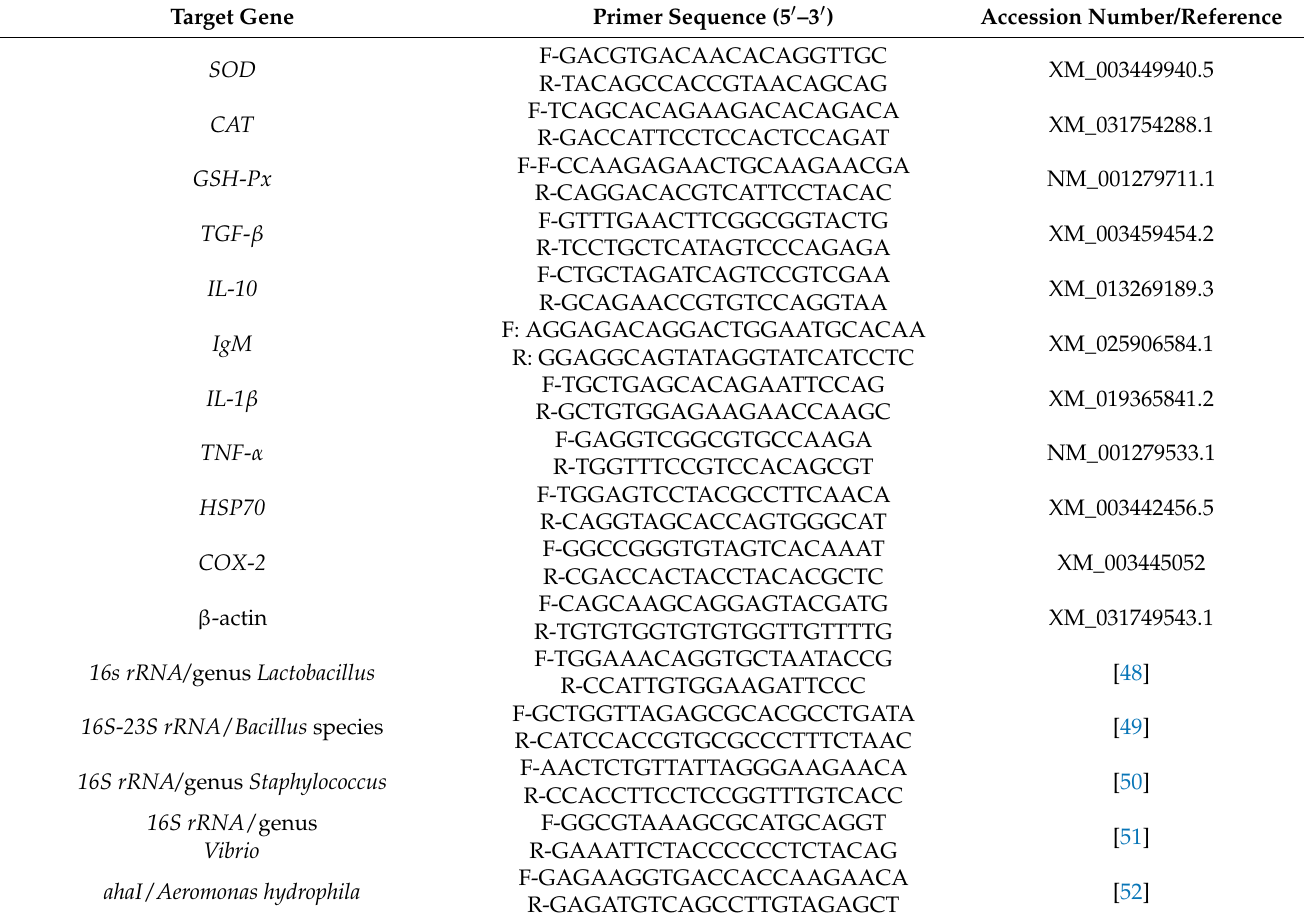
Table 2. Primer sequences utilized for PCR